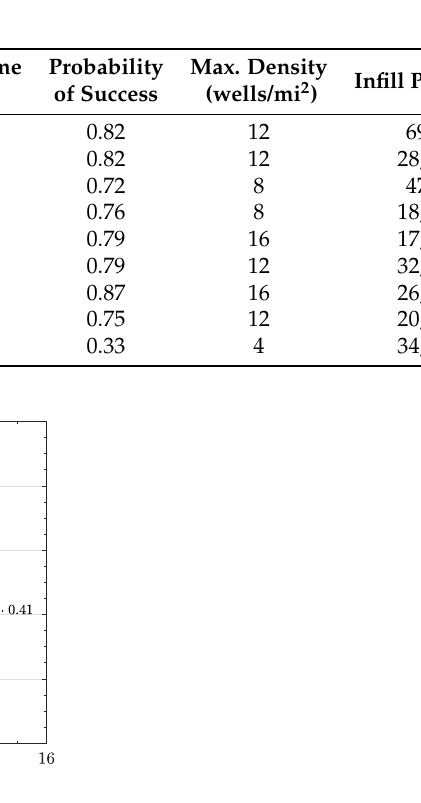
Figure 8. Well survival probability example from the Delaware Bonespring Core. The maximum survival time for this Permian region is about 10.8